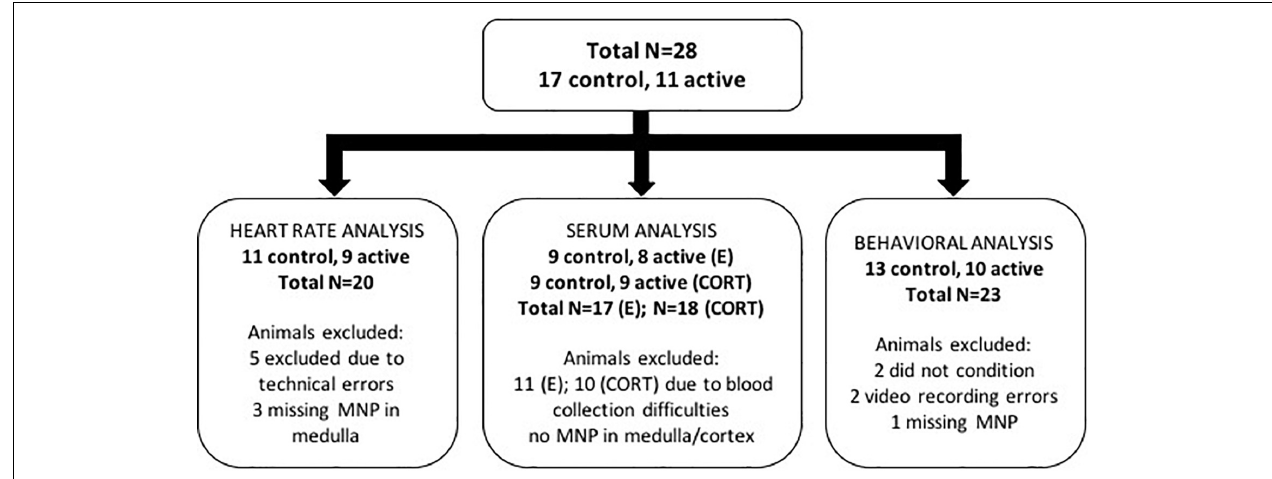
FIGURE 2 | Summary chart of animal exclusions by analysis. A total of 28 rats were used in this study. Of these 28 animals, a number of animals were excluded from each of the heart rate, serum, and behavioral analyses for the reasons described in the